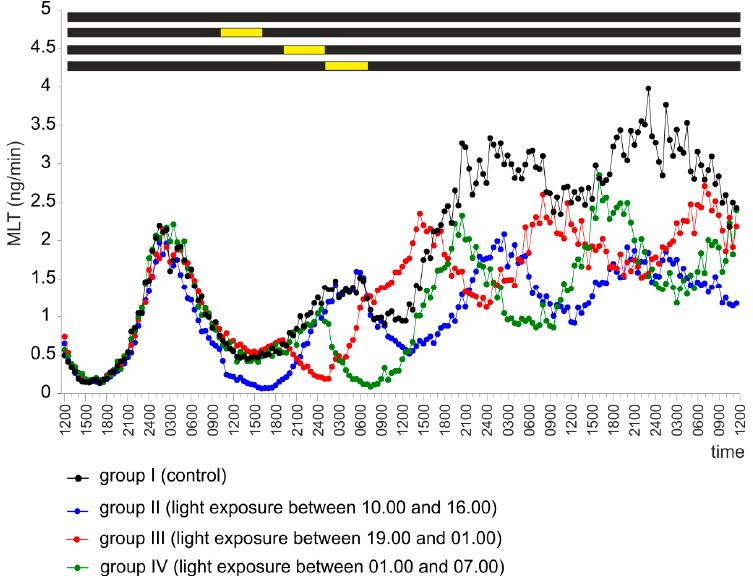
Figure 6. Experiment III. Secretion of MLT (mean) from turkey pineal organs incubated for four days in continuous darkness. During the second day of the experiment, the explants from groups II, III, and IV were exposed to fluorescent light with an intensity of 100 lx between 10.00 and 16.00 (group II), between 19.00 and 01.00 (group III), or between 01.00 and 07.00 (group